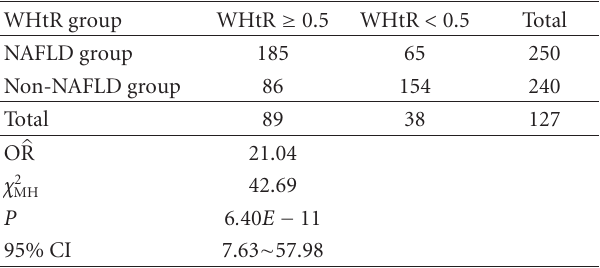
Table 4: Correlation between WHtR and NAFLD.